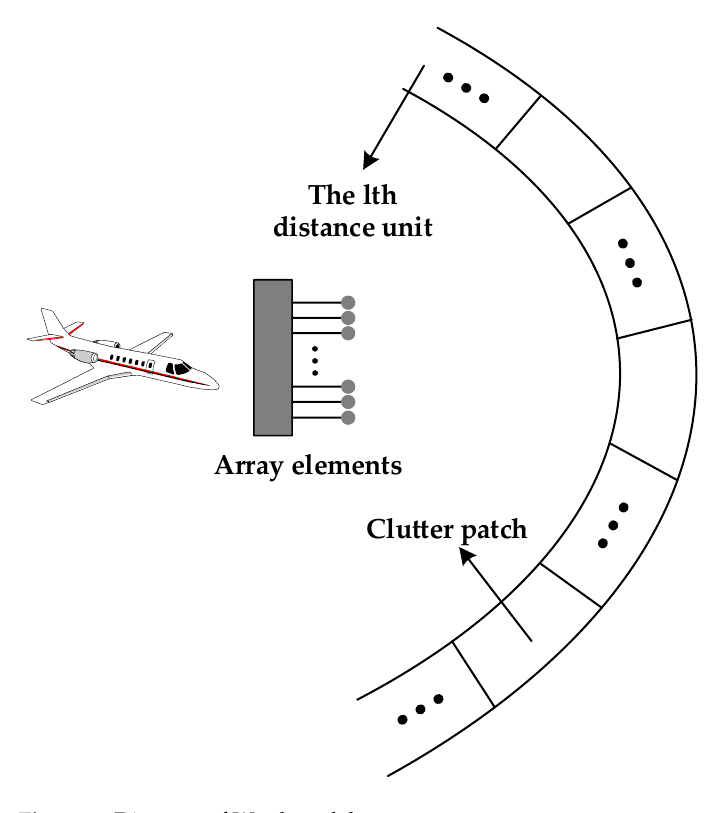
Figure 2. Diagram of Ward model.